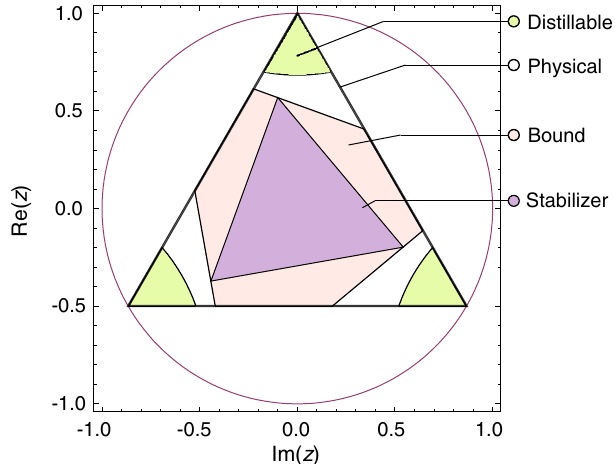
FIG. 2. The canonical C plane for a qutrit, d ¼ 3 , onto which M twirling. Every quantum state any state can be projected by C M ¼ is a point in the complex plane for the complex number z (cid:1) i , take values z ¼ (cid:1) Þ . The three pure magic states, j M tr ð C M k 1 ; !; ! 2 , which have j z j 2 ¼ 1 and so lie on a circle in the plane. (cid:3) f Þ þ !f þ ! 2 f , and All physical states have z ¼ ð 1 (cid:3) f 1 2 1 2 so lie in the convex hull of the pure magic states, forming a triangle of physical states. The distillable region of states can, by ð 2 Þ protocol, be brought arbitrarily close to use of the QRM 3 the nearest pure magic state. The stabilizer states are the convex hull over the set of points, z , taken for each of the pure stabilizer states. It is impossible to distill not only the stabilizer states but also the bound states, as demonstrated in Ref. [42]. Note that the rotational symmetry is to be expected, as the Pauli Z rotation performs a rotation in the C M